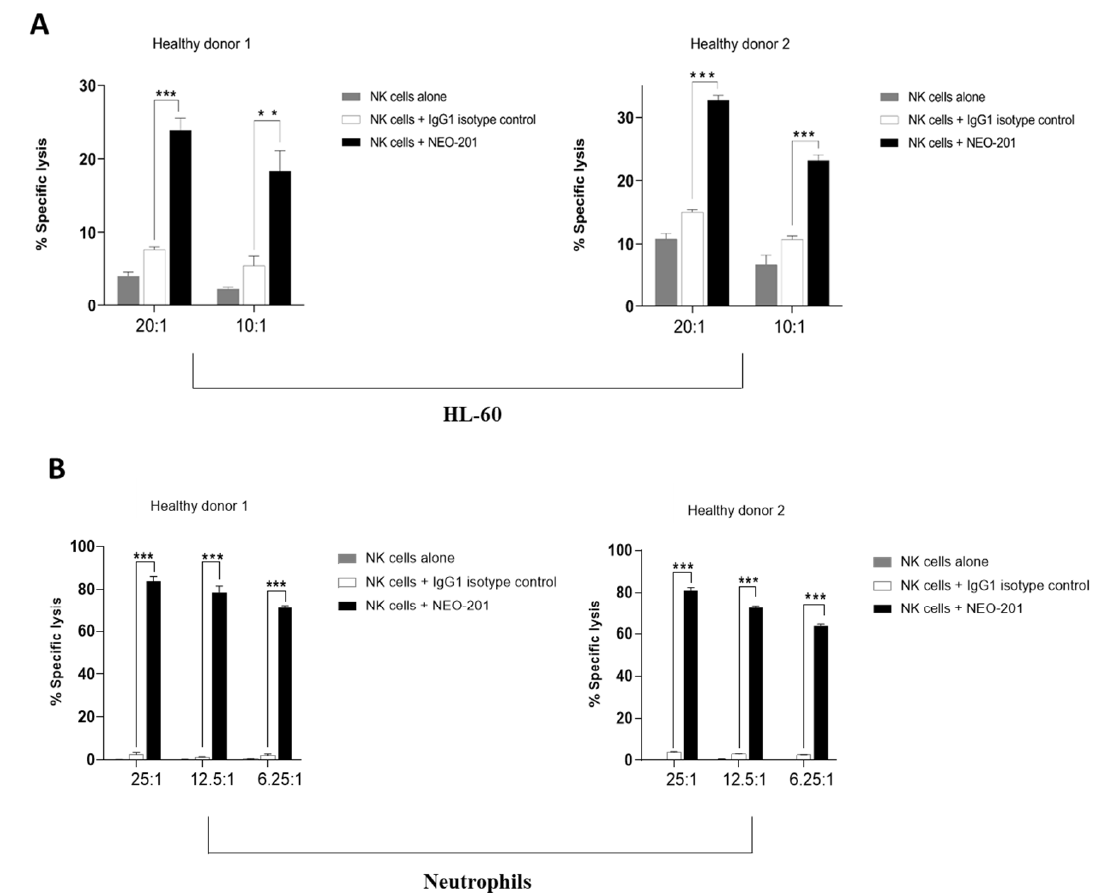
Figure 4. NEO-201 kills cancer cells expressing core 1 and/or extended core 1 O-glycans through ADCC. The HL-60 cell line and human neutrophils have been used as target cells to evaluate the ADCC mediated by NEO-201 in the ADCC assay. Cells were incubated with 10 µ g/mL of NEO-201 or human IgG1 (negative control). NK cells from two healthy donors were used as effector cells at the indicated E:T ratios. Results are presented as the mean of % specific lysis ± SD (standard deviation) from three replicate wells in each experiment. *** statistically significant ( p < 0.001) by two-way ANOVA (NEO-201 + NK cells vs. IgG1+ NK cells). ** statistically significant ( p < 0.01) by two-way ANOVA (NEO-201 + NK cells vs. IgG1+ NK cells).